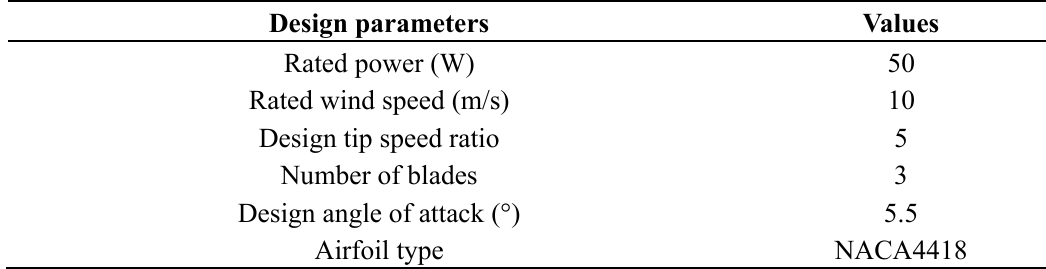
Table 1. The blade design parameters of OPT blade.